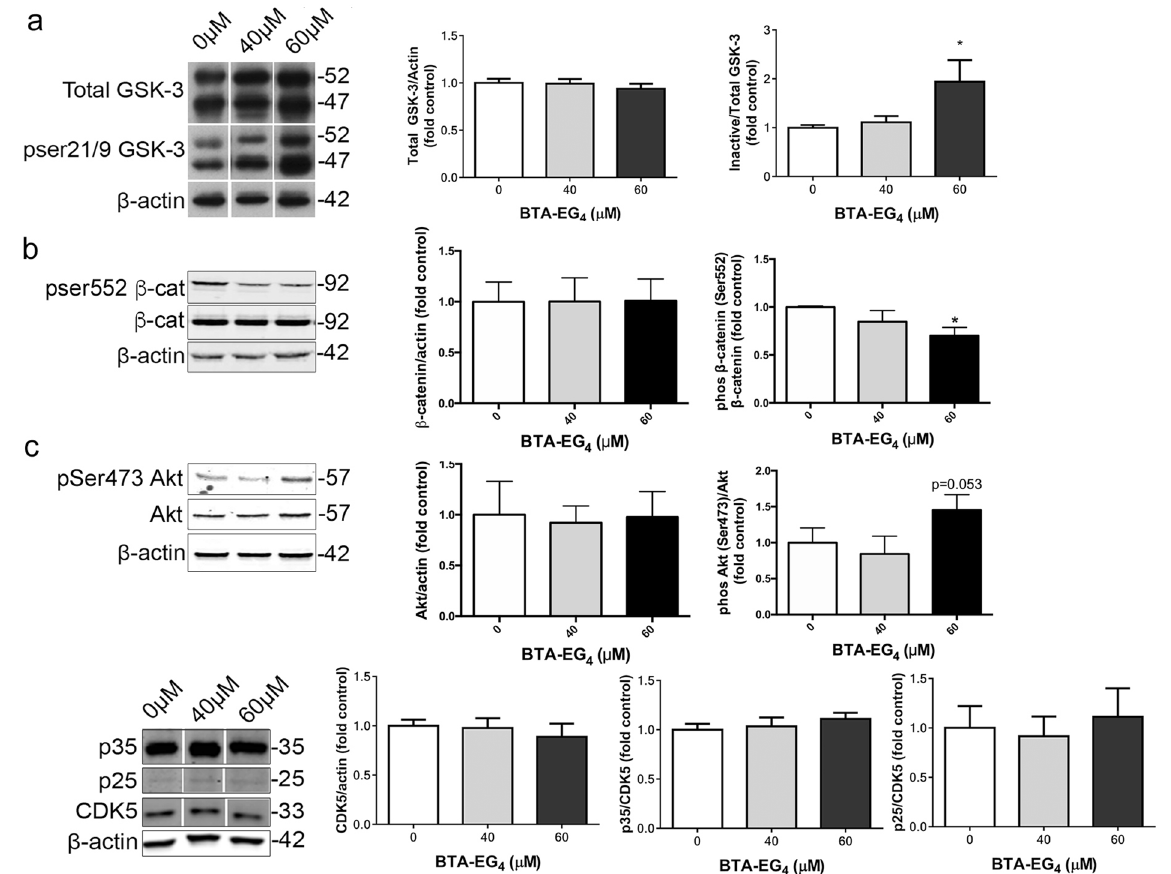
Figure 6. BTA-EG 4 inhibits GSK-3 but not Cdk5 in 3xTg-AD slice cultures. Representative western blots of lysates following 48 h 40–60 μ M BTA-EG 4 and control (DMSO, 0 μ M) treatment of 3xTg-AD slice cultures. ( a ) Blots were probed with antibodies against total GSK-3 α / β and inactive GSK-3 α / β (phosphorylated at ser 21/9). Bar chart shows amounts of total GSK-3 relative to β -actin and GSK-3 phosphorylated at ser 21/9 (inactive) as a proportion of total GSK-3, n = 12. ( b ) Western blots of β -catenin and β -catenin phosphorylated at ser 552, total Akt and active Akt (phosphorylated at ser 473), together with β -actin as a loading control. Bar charts show p- β -catenin relative to total β -catenin and β -catenin following normalisation to β -actin, and p-Akt relative to Akt and total Akt following normalisation to β -actin, n = 3. ( c ) Samples were immunoblotted with antibodies against cdk5, p35 (which also detects p25) β -actin. Bar charts show total Cdk5 relative to β -actin and